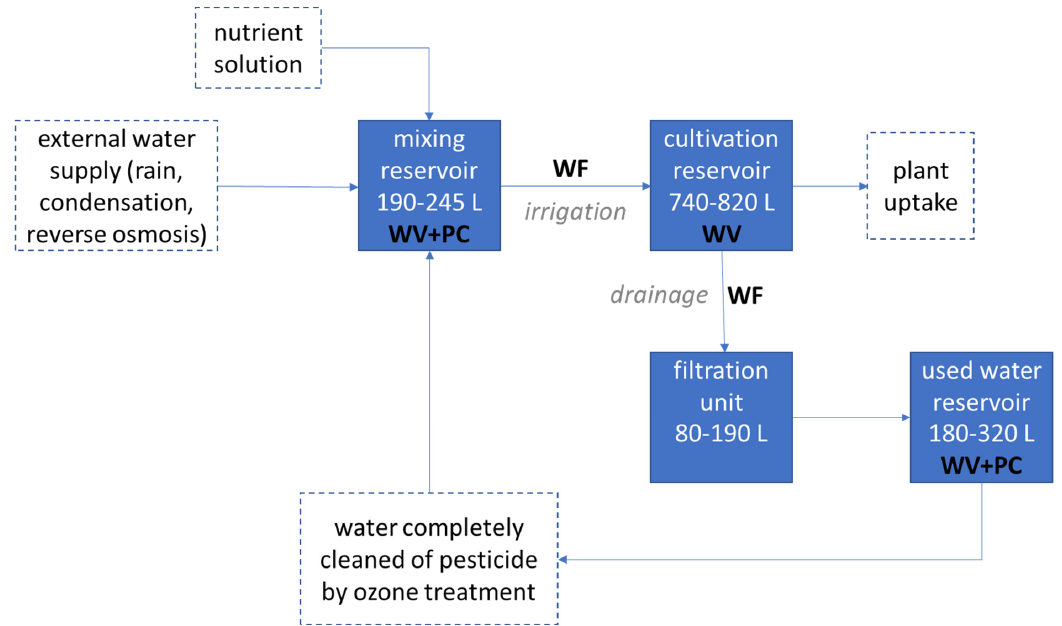
Figure 3. Schematic representation of the greenhouse system. The numbers indicate the range of the volumes of water in the reservoirs, WV indicates that the water volume in the reservoir was measured, WF indicates that the water flow rate was measured between the reservoirs in total volume per 5 min, and PC indicates that the pesticide concentration was measured in the reservoir. The blue boxes are considered in the model testing.